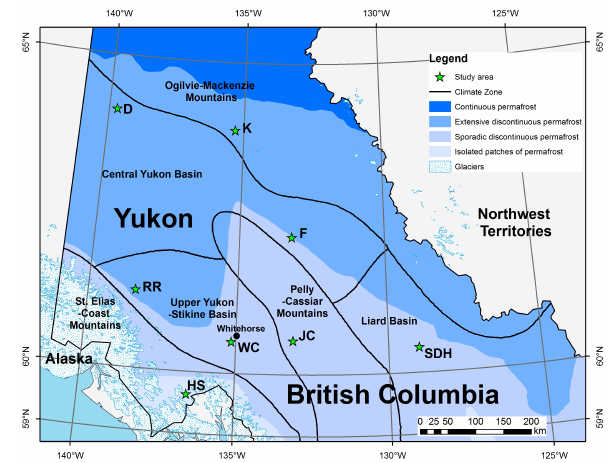
Fig. 1. Map of the study region showing intensive modelling sites (see Bonnaventure et al., 2012b) in relation to permafrost zones (Heginbottom et al., 1995) and climatic regions (Wahl et al., 1987). JC: Johnson’s Crossing, SDH: Sa Dena Hes, F: Faro, K: Keno, D: Dawson, RR: Ruby Range, HS: Haines Summit and WC: Wolf